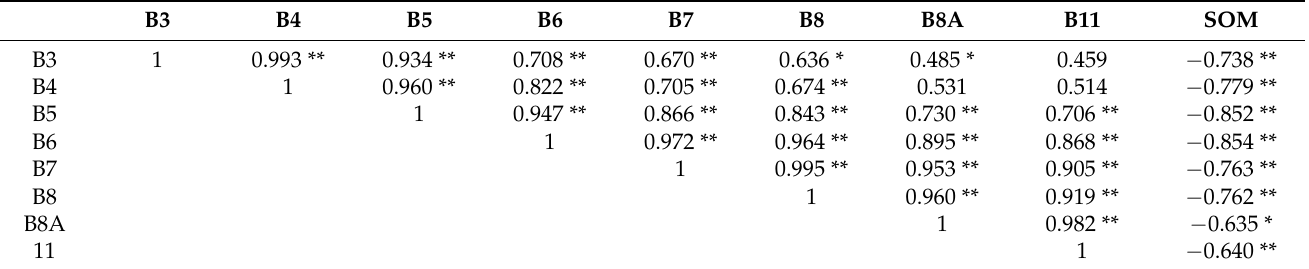
Table 3. The correlation between original image data and